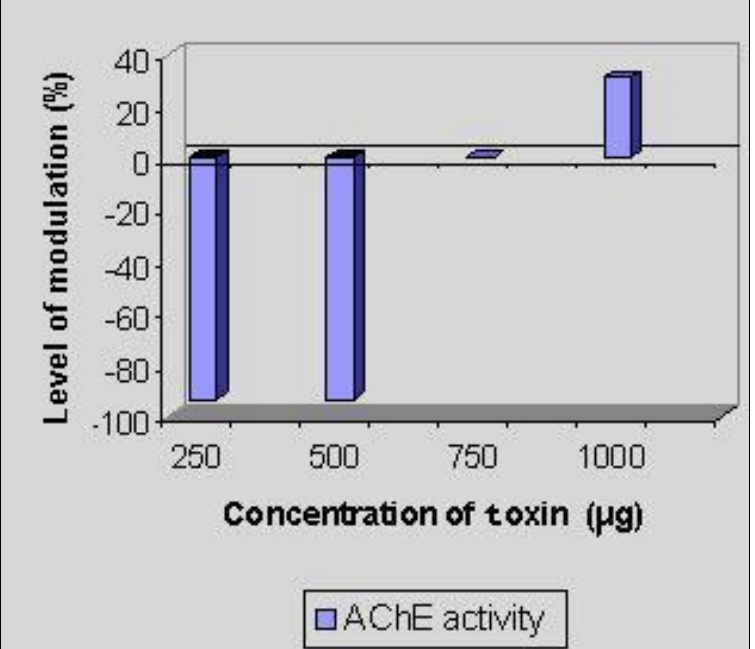
Figure 4. Modulation of AChE activity by the methanolic extract of Halichondria